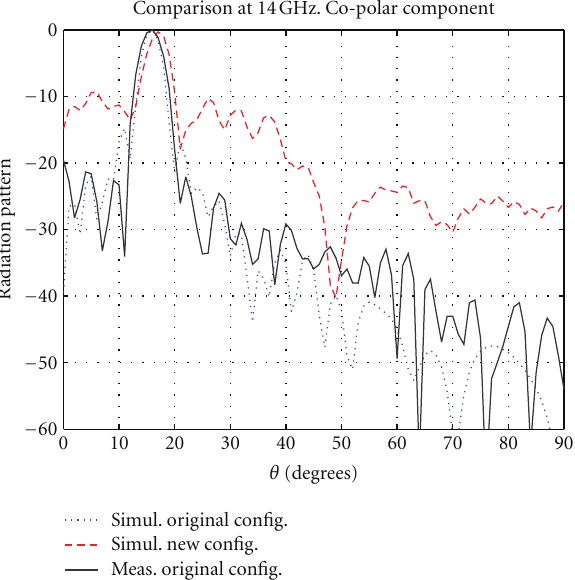
Simul. original config. Simul. new config. Meas. original config. Figure 8: Radiation pattern of the original and modified configu- rations. Copolar component.